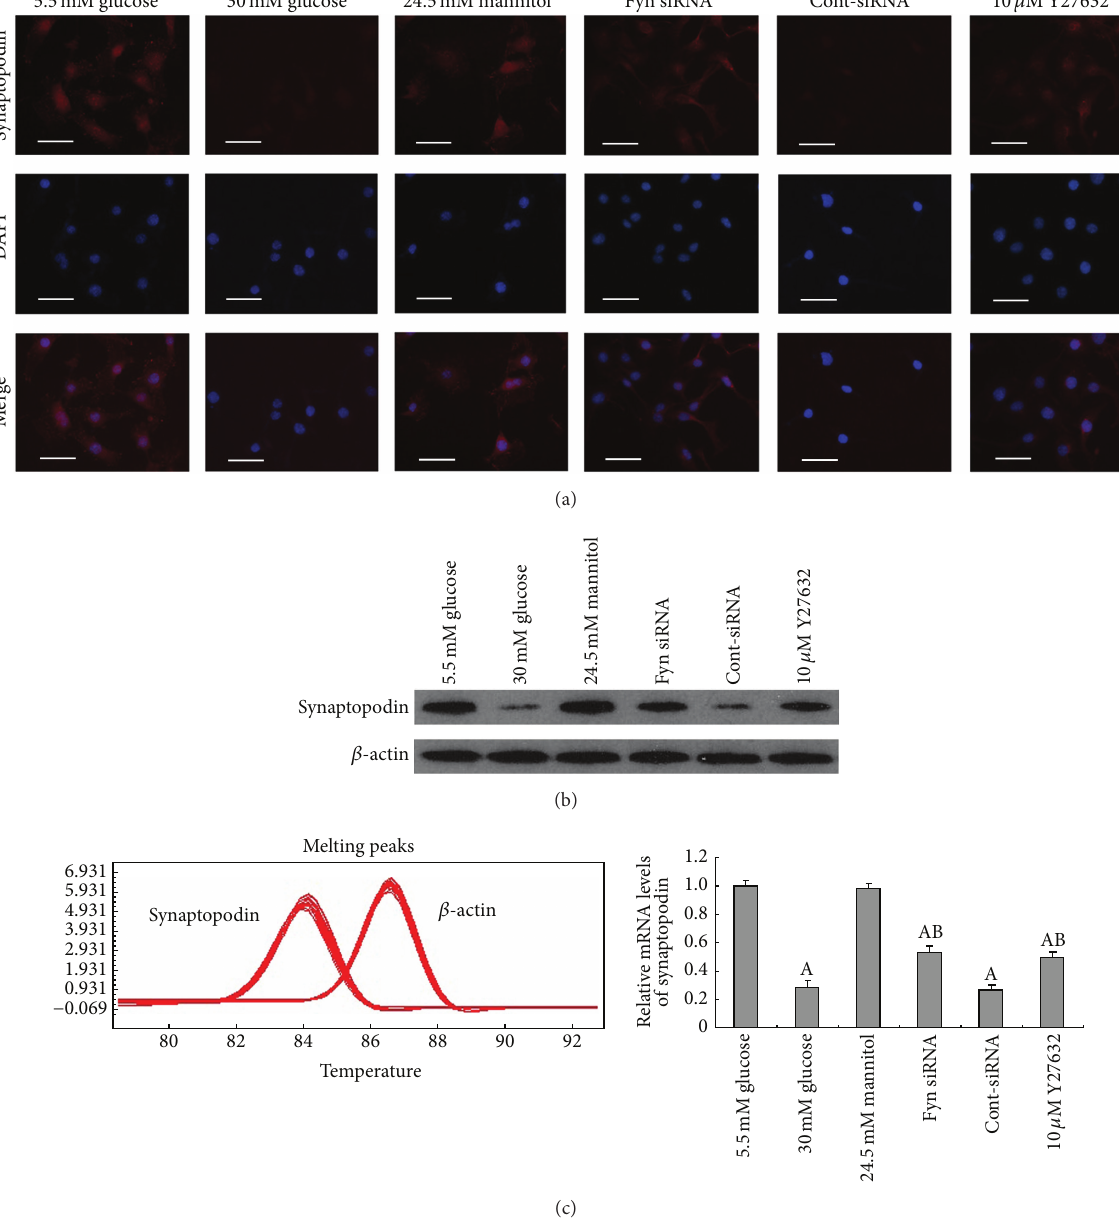
Figure 2: Alterations of protein and mRNA levels of synaptopodin in podocytes. Immunofluorescence (a), western blot (b), and real-time PCR (c) revealed that synaptopodin expression was markedly decreased following 48-hour incubation with 30 mM glucose (column 2) when compared with cells incubated in 5.5 mM glucose (column 1) on both protein and mRNA levels. Transfection with Fyn siRNA (column 4) or pretreatment with 10 𝜇 M Y27632 for 30 minutes (column 6) partially reversed these alterations. Control podocytes were treated with 5.5 mM glucose plus 24.5 mM mannitol (column 3) or transfected with Cont-siRNA (column 5). Magnification: 400x. Values denote the mean ± SD; A 𝑃 < 0.05 versus 5.5 mM glucose and B 𝑃 < 0.05 versus 30 mM